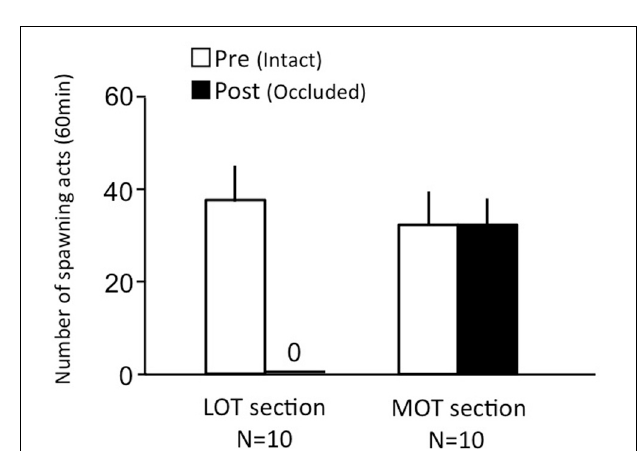
FIGURE 3 | Effects of nasal occlusion on female sexual behavior in female goldfish. Pre, Pre-treatment (open column). Post, post-treatment (solid column). Each column represents the mean and s.e.m. Difference compared to pre-treatment (asterisk), p < 0 . 05.